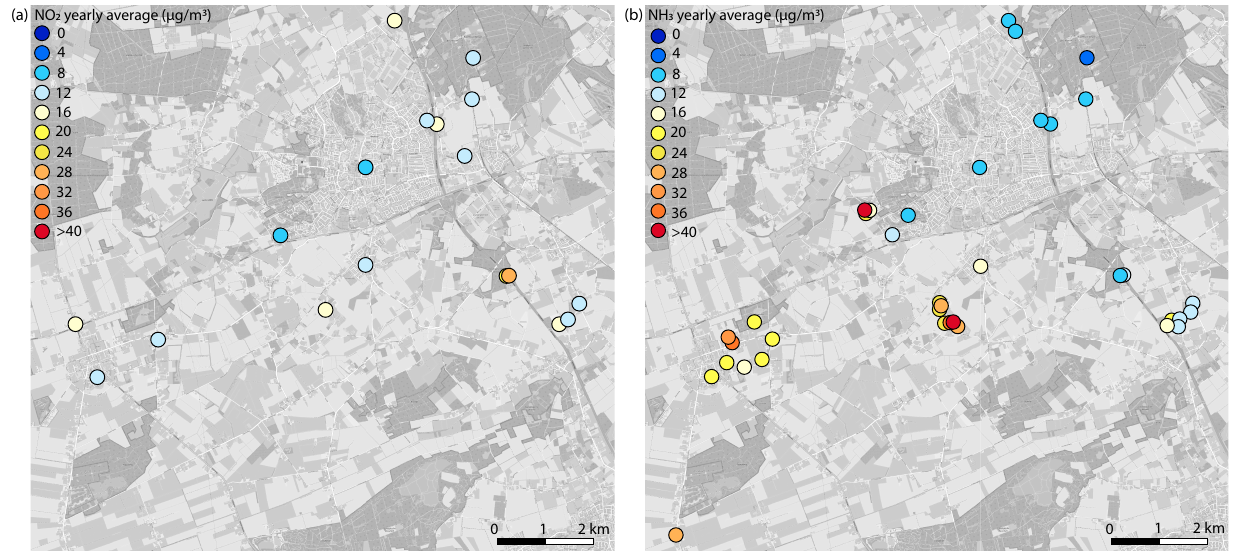
Figure 7. Maps with yearly average concentrations of ( a ) NO 2 in µ g/m 3 and ( b ) NH 3 in µ g/m 3 . ©OpenStreetMap